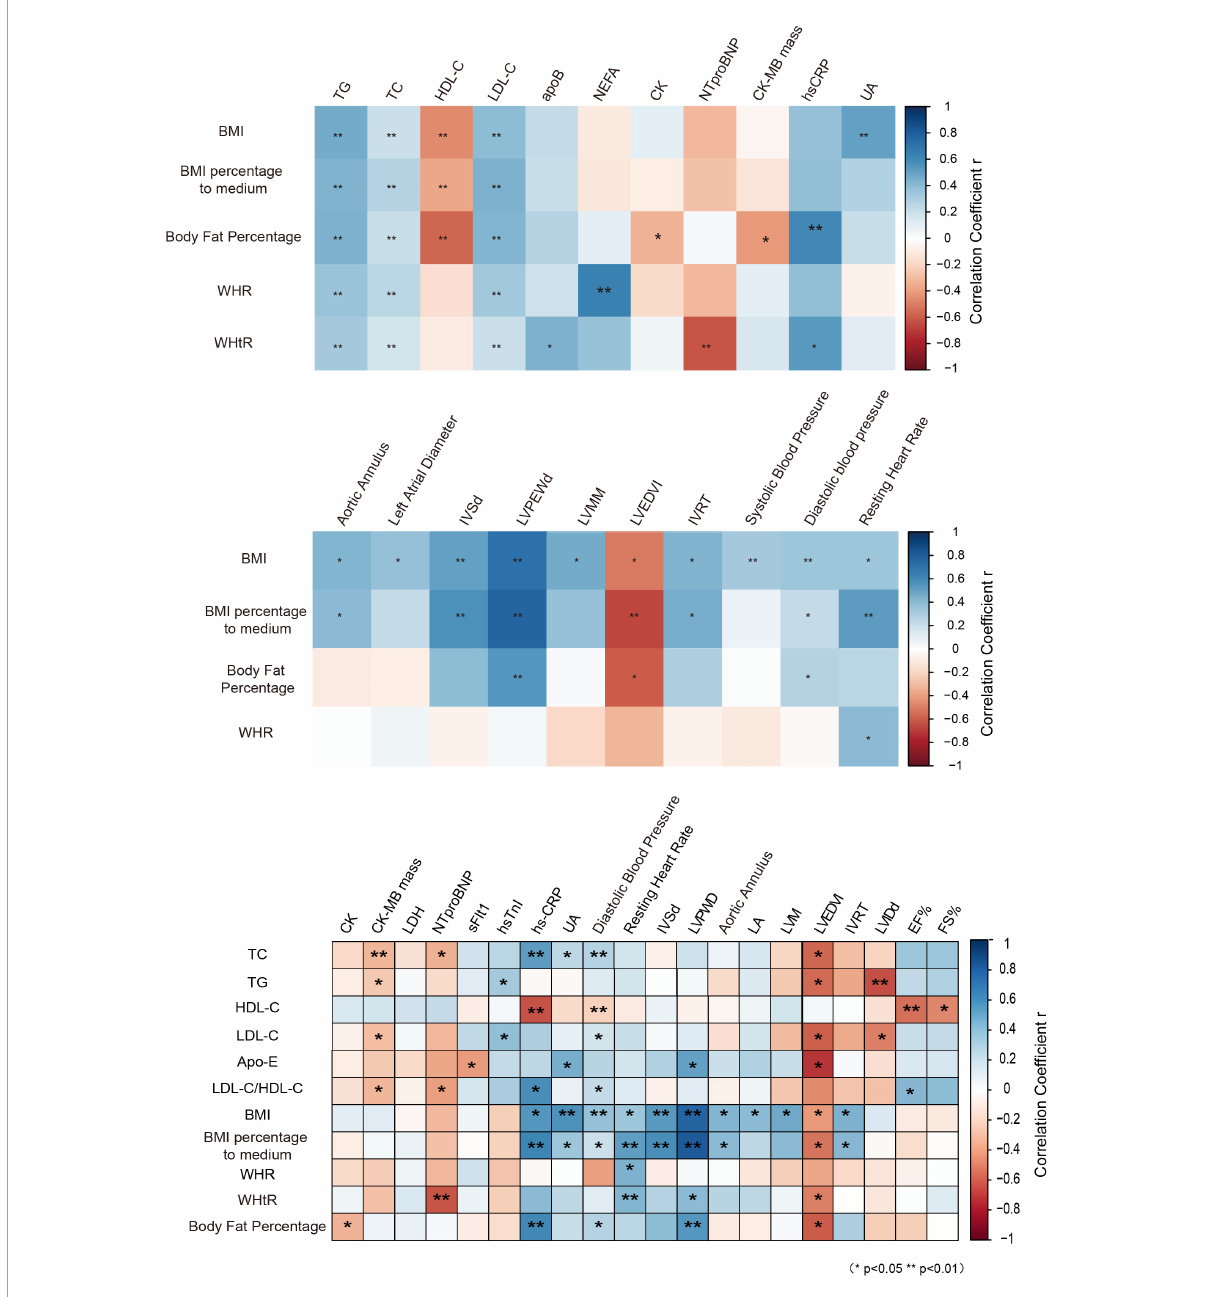
FIGURE5 Correlation analysis of obesity indicators with cardiovascular risk factors. BMI, body mass index; WHR, waist-to-hip ratio; WHtR, waist-to-height ratio; NEFA, non-esterified fatty acids; apoB, apolipoprotein B; NTproBNP, N-terminal pro-brain natriuretic peptide; CK-MB mass, creatine kinase-MB mass; AO, aortic annulus; LA, left atrial diameter; IVSd, interventricular septal wall thickness at end diastole; LVPWD, left ventricular posterior wall thickness at end diastole; LVM, left ventricular mass; LVMM, left ventricle myocardial mass; LVEDVI, left ventricular end-diastolic volume index; IVRT, isovolumetric relaxation time; LVIDd, end-diastolic left ventricular internal diameter; EF%, left ventricular ejection fraction; FS%, fractional